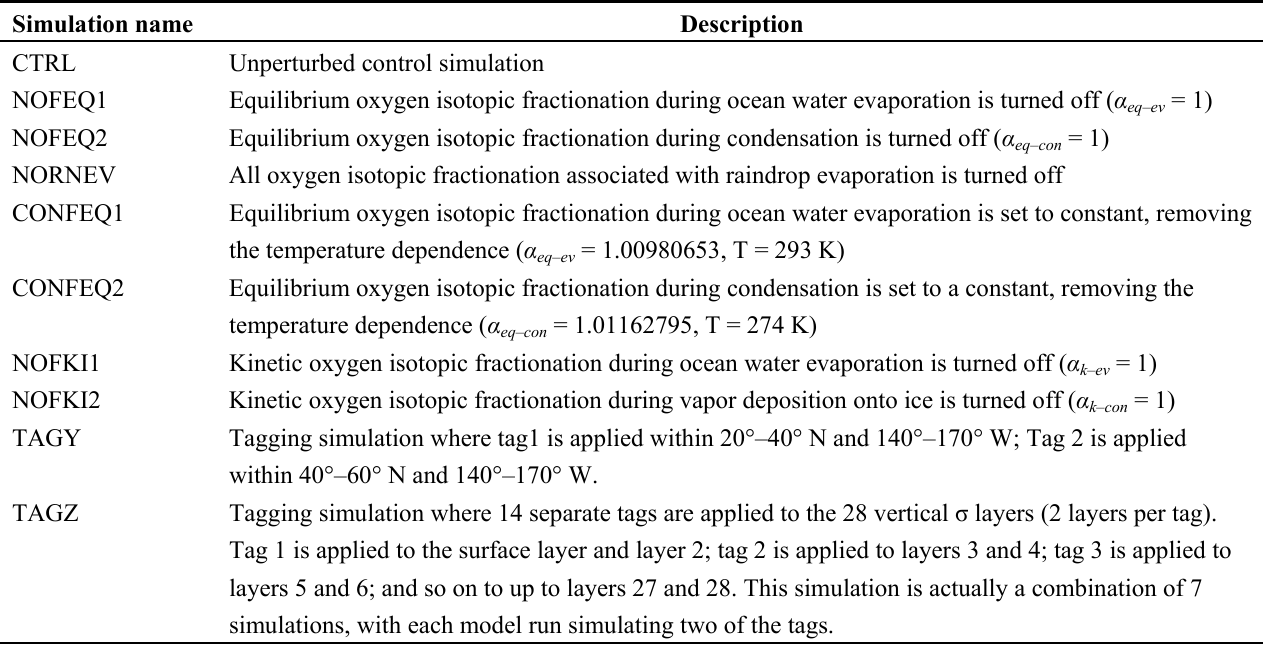
Table 1. Name and description of Isotope-incorporated Global Spectral Model (IsoGSM)